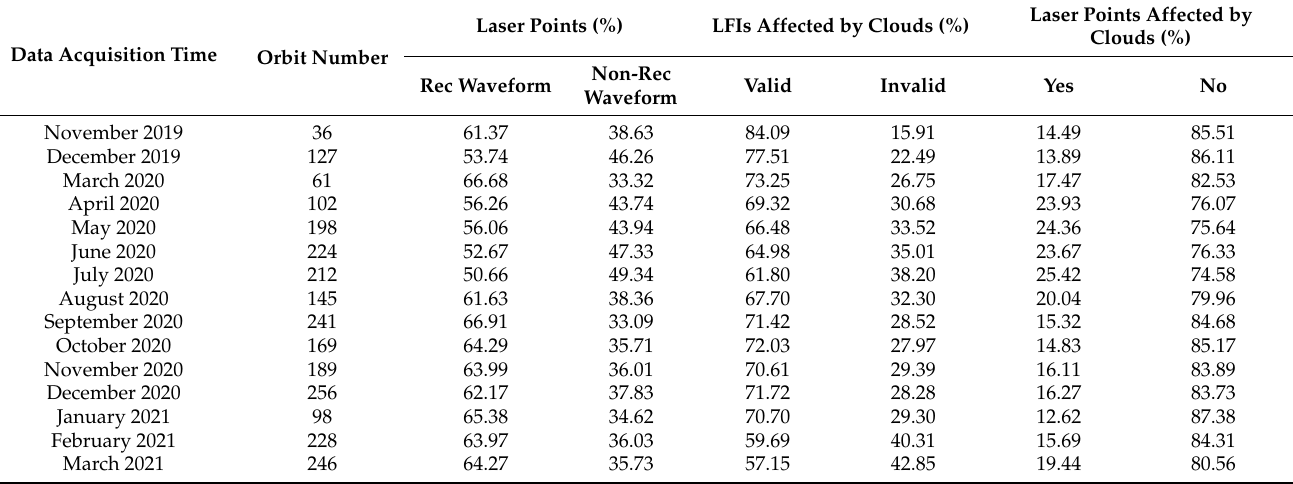
Table 4. Laser data statistics since the launch of the GF-7